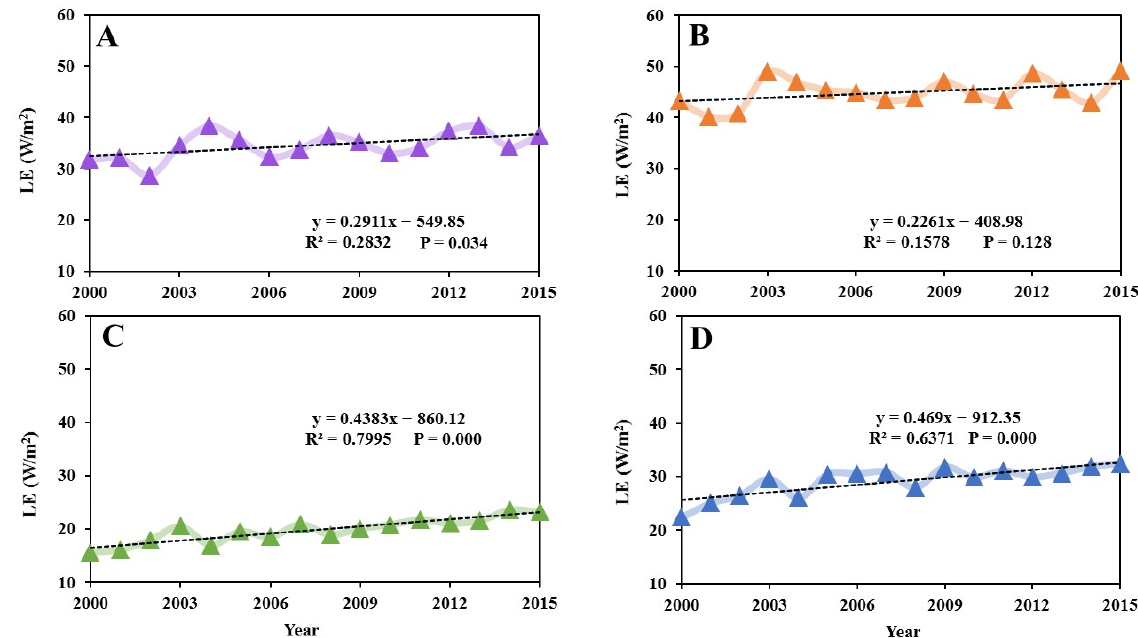
Figure 16. Trend of LE from 2000 to 2015 (( A ) Jinan City, ( B ) Zhengzhou City, ( C ) Lanzhou City, ( D ) Xining City).